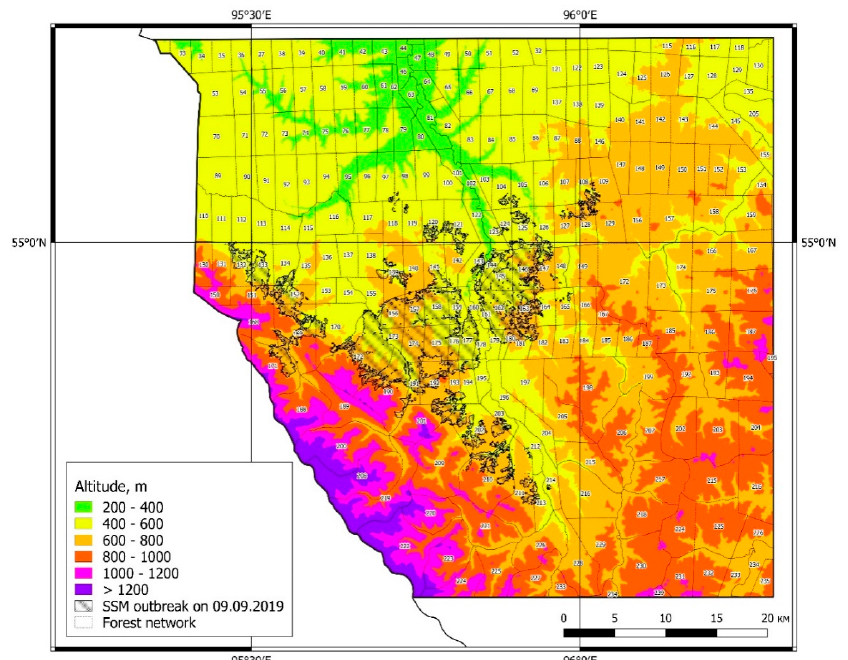
Figure 3. A digital elevation model representing the areas of dark coniferous stands damaged by the Siberian silk moth, depending on the height above sea level. Legend: green background—areas located at an altitude of 200 to 400 m, yellow—from 400 to 600 m, orange—from 600 to 800 m, red—from 800 to 1000 m, pink—from 1000. to 1200 m, blue—more than 1200 m; and black shading—boundaries of the forest defoliated during the outbreak as of 9 September 2019.